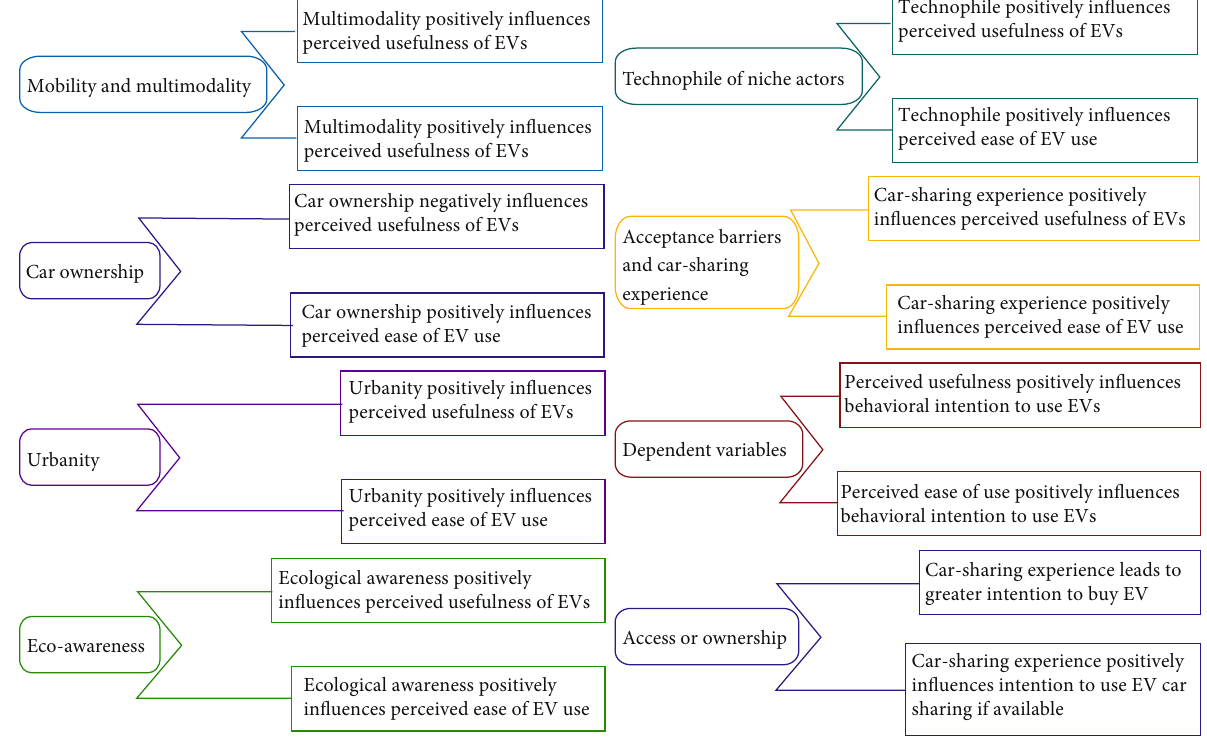
Figure 16: A mobility research